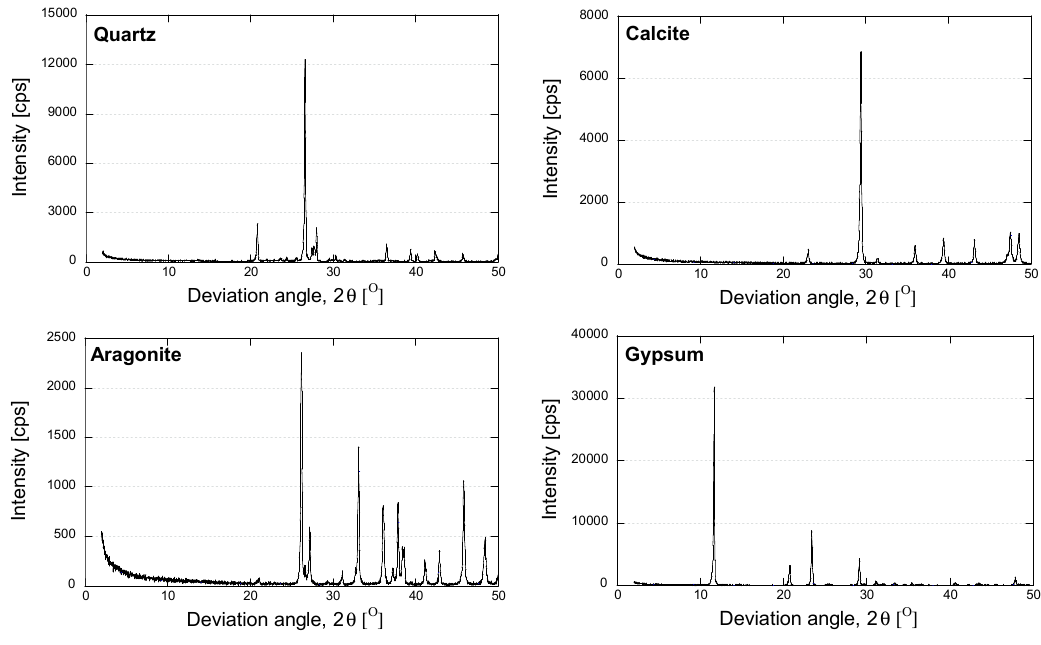
Figure 6. X-ray diffraction results of internal standard and pure minerals.